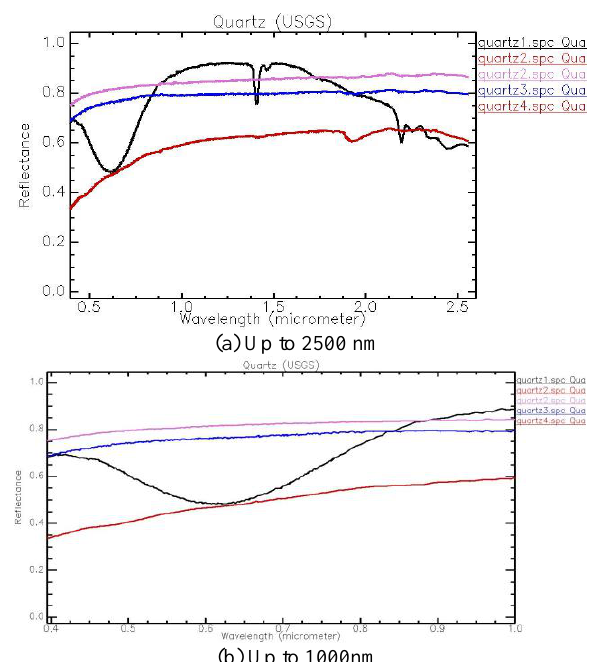
Figure 8. Consolidated End members after the application of EVRR (based on Figure